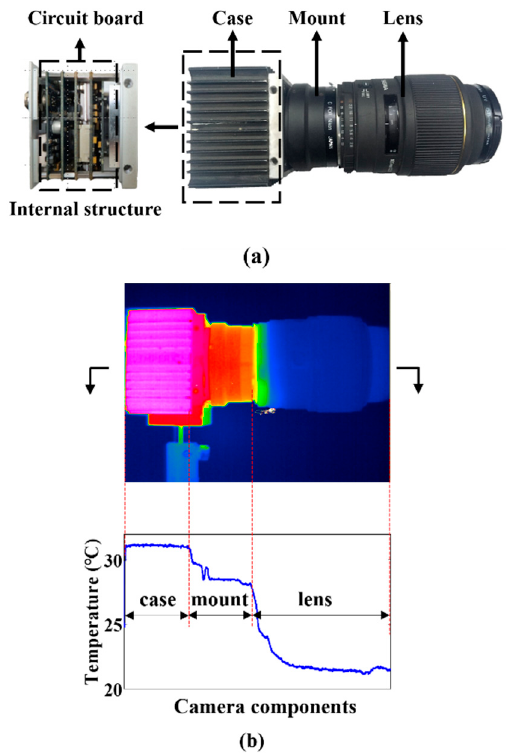
Figure 1. ( a ) Structural composition and ( b ) temperature distribution of typical digital camera system monitored by infrared camera.